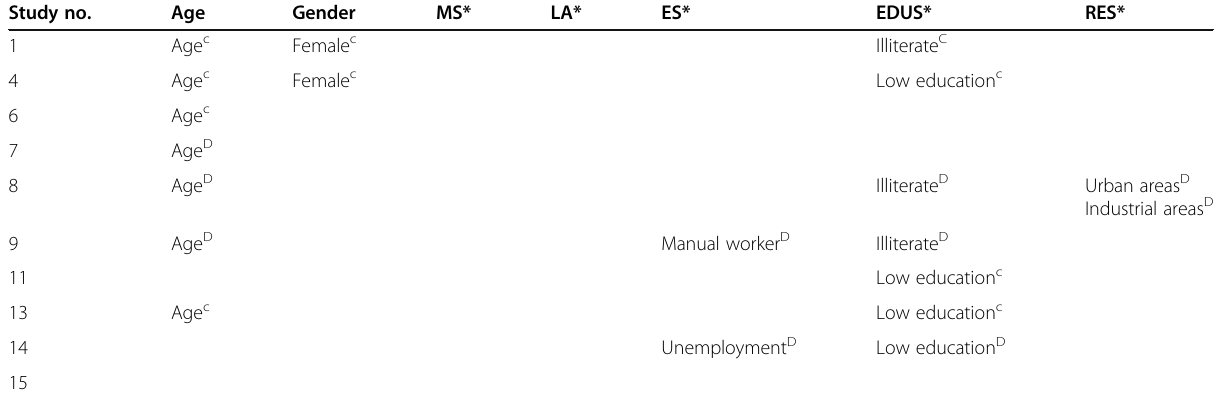
Table 6 Reported significant positive correlation of cognitive impairment and dementia with sociodemographic status Study